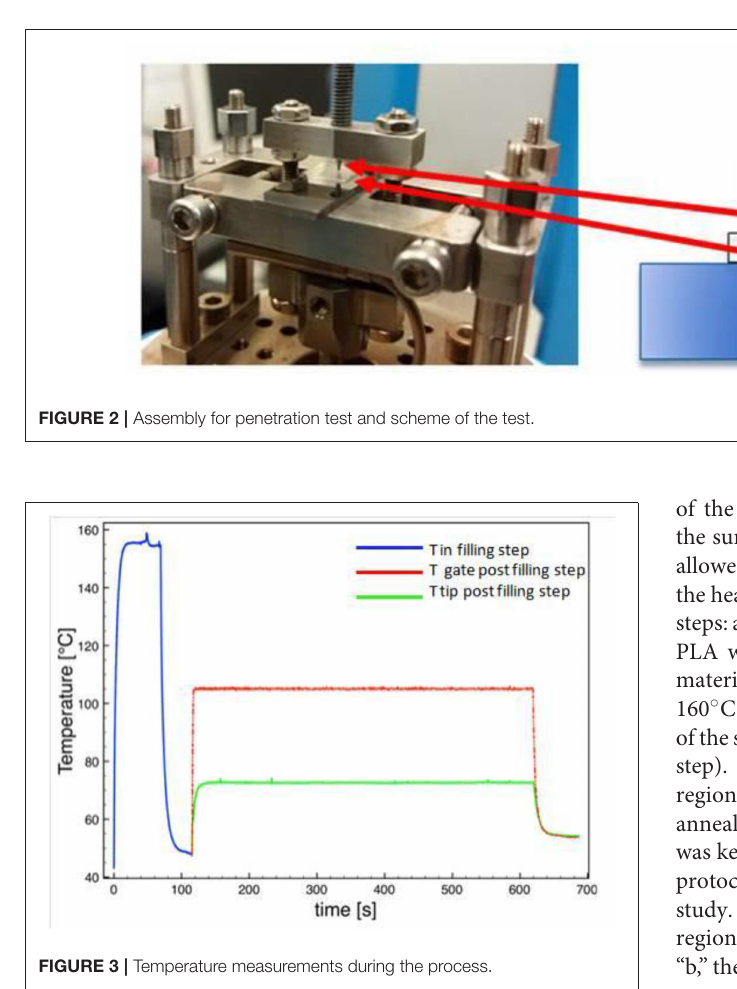
FIGURE 1 | Schematic of the steps for the parts production.